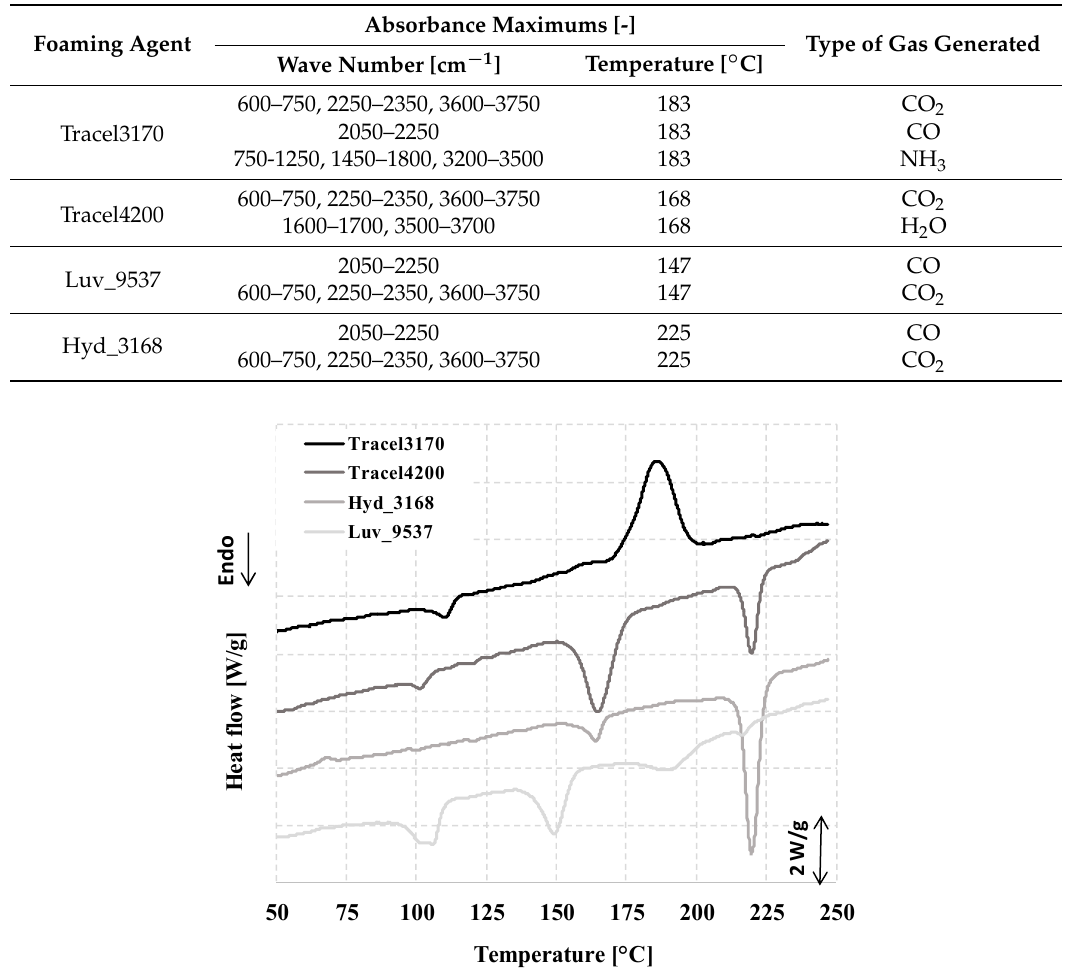
Figure 5. Differential scanning calorimetry (DSC) results of foaming agents (50–250°C, first heating, 10 °C/min). Table 4. Comparison of decomposition processes registered with DSC and TGA tests.